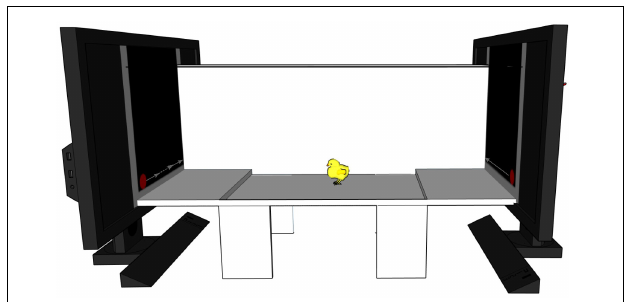
FIGURE 4 | Schematic representation of the experimental apparatus. A white corridor with two video-screens at the two opposite ends playing the stimuli. On the left monitor is depicted the stimulus changing speed (dotted line represents faster speed), on the right monitor is represented the constant moving stimulus. The chick is represented in the starting area at the centre. Two little steps divide it from the two choice areas. For representative purposes one of the two longitudinal walls is represented